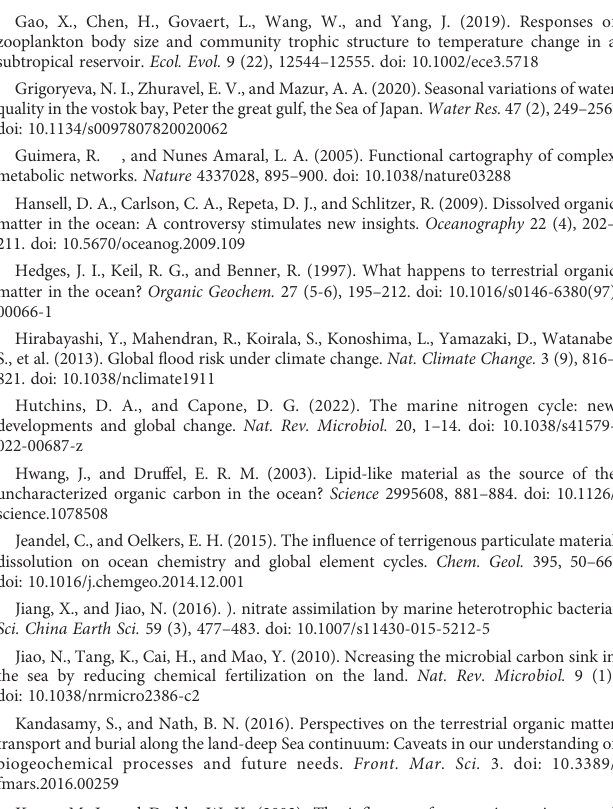
Figueroa, D., Capo, E., Lindh, M. V., Rowe, O. F., Paczkowska, J., Pinhassi, J., et al. (2021). Terrestrial dissolved organic matter in fl ow drives temporal dynamics of